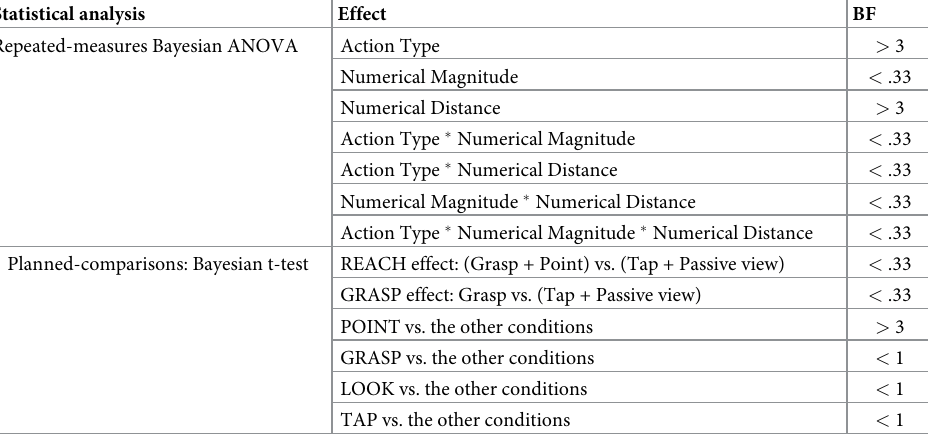
Table 2. Schematic summary of the results from the repeated-measures Bayesian ANOVA and resulting planned-